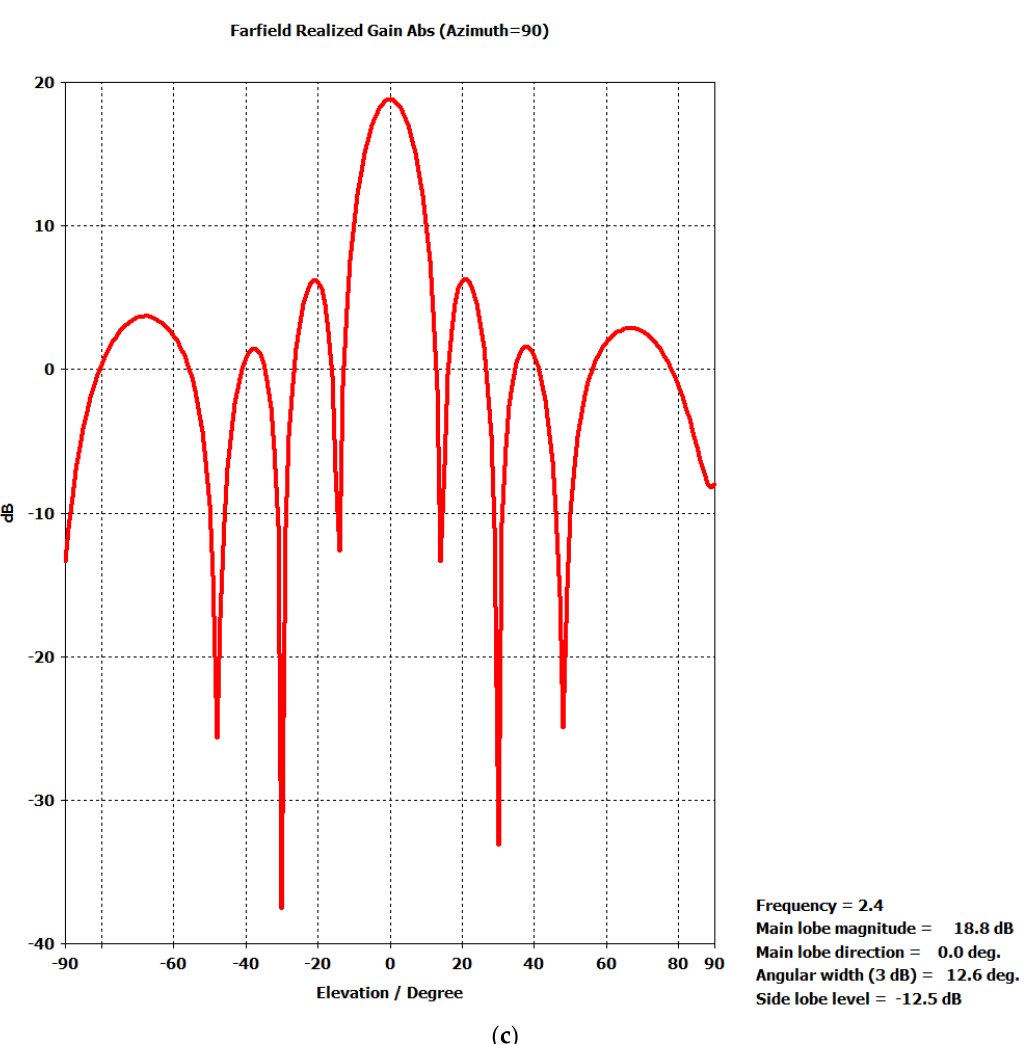
Figure 15. ( a ) Array pattern of 4 × 4 Yagi–Uda elements—3D view (Gain, Realized gain); ( b ) Array pattern of 4 × 4 Yagi–Uda elements—Azimuth’s cartesian view; ( c ) Array pattern of 4 × 4 Yagi–Uda elements—Elevation’s cartesian view.